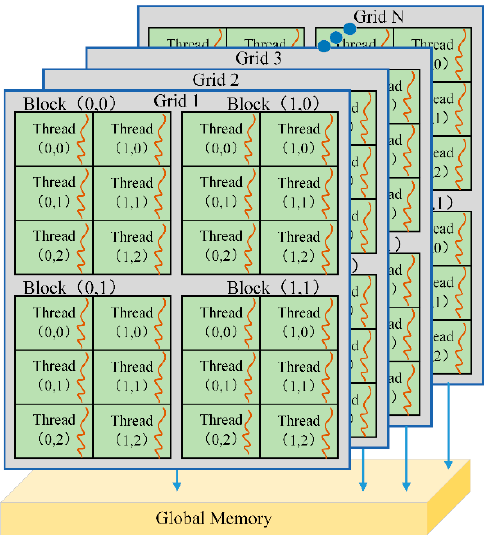
Figure 5. The processing architecture of compute unified device architecture (CUDA).